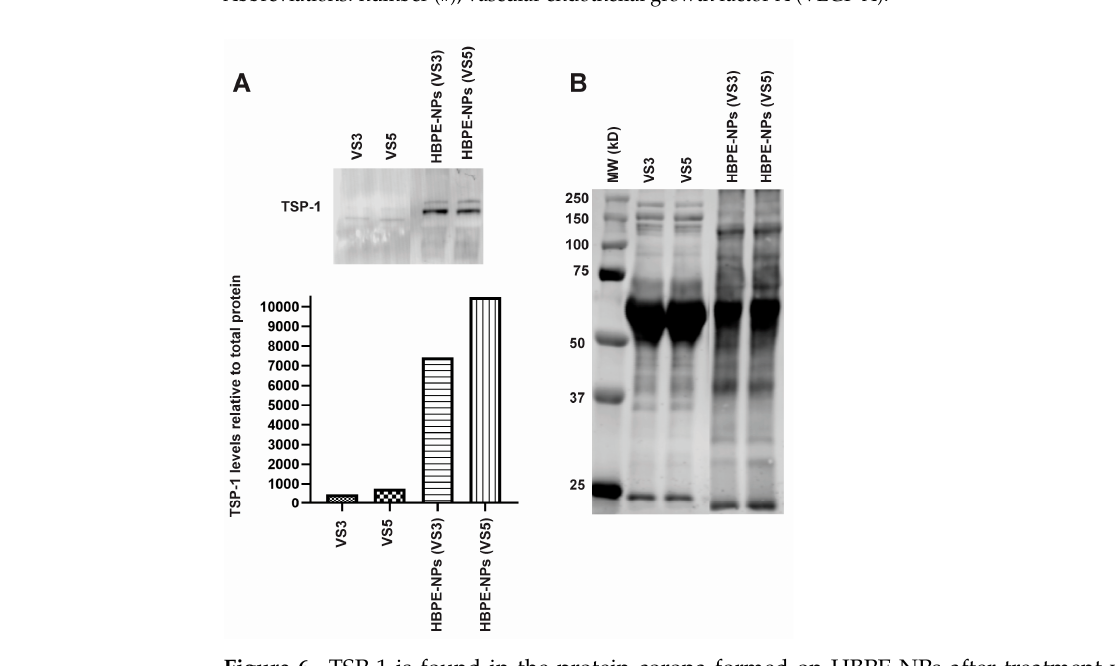
(Table 4) and indicating that HBPE-NPs may selectively absorb proteins from sera. Note that equivalent protein amounts were loaded in each sample. Abbreviations: number (#), vascular endothelial growth factor A (VEGF-A).